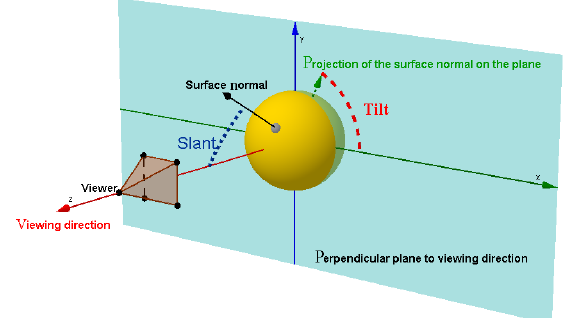
Fig. 7 Slant and tilt angular variables are important parameters for encoding 3D perceptions in our brain [53, 54]. The tilt of a surface corresponds to the direction of largest variation in perceived distance while slant varies with the magnitude of the gradient according to Eq. (42).